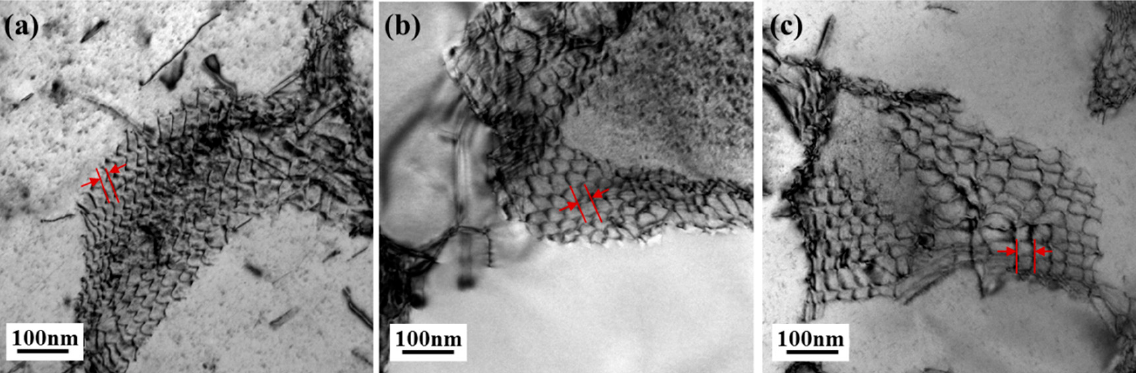
Figure 13. The dislocation network formed in samples interrupted by creep 1100 °C/137 MPa for 10 h: ( a ) WQ sample, ( b ) AC sample and ( c ) HT sample. (Beam = [001], the spacing of the dislocation network is marked by red arrows). Table 6. γ - and γ′ phase compositions after interruption of crept 10 h (at.%).